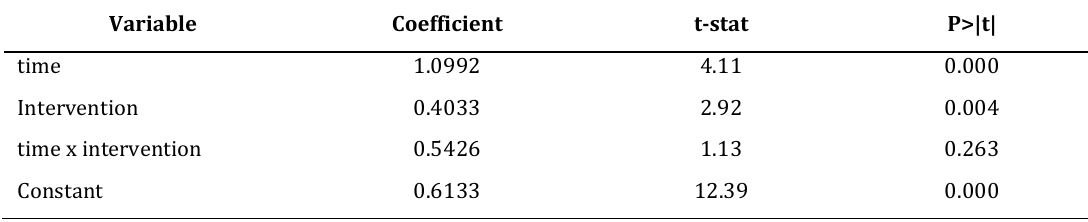
Table 9: The impact of EU entrance in the EU in terms of FDI compared to Norway Variable Coefficient t-stat P>|t| time 1.0992 4.11 0.000 Intervention 0.4033 2.92 0.004 time x intervention 0.5426 1.13 0.263 Constant 0.6133 12.39 0.000